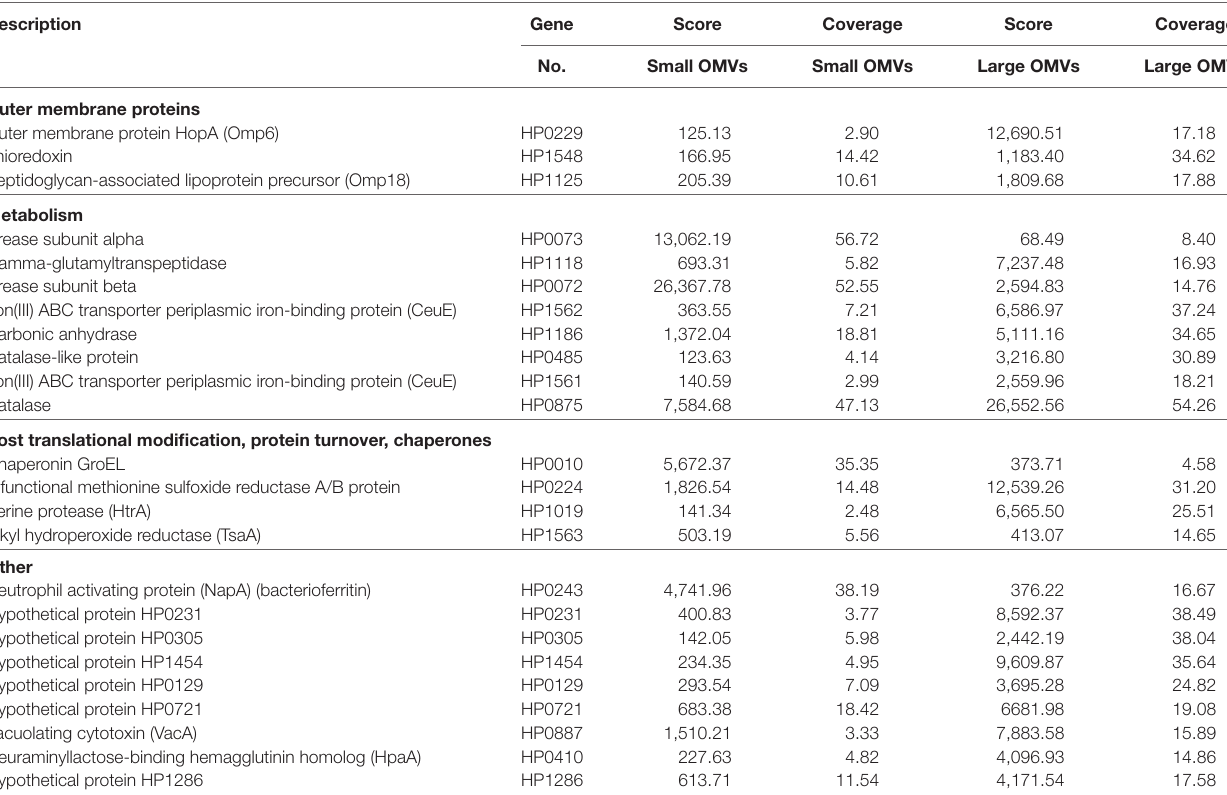
TaBle 1 | Helicobacter pylori proteins common in both small and large outer membrane vesicles (OMVs) (fractions 6 and 12).